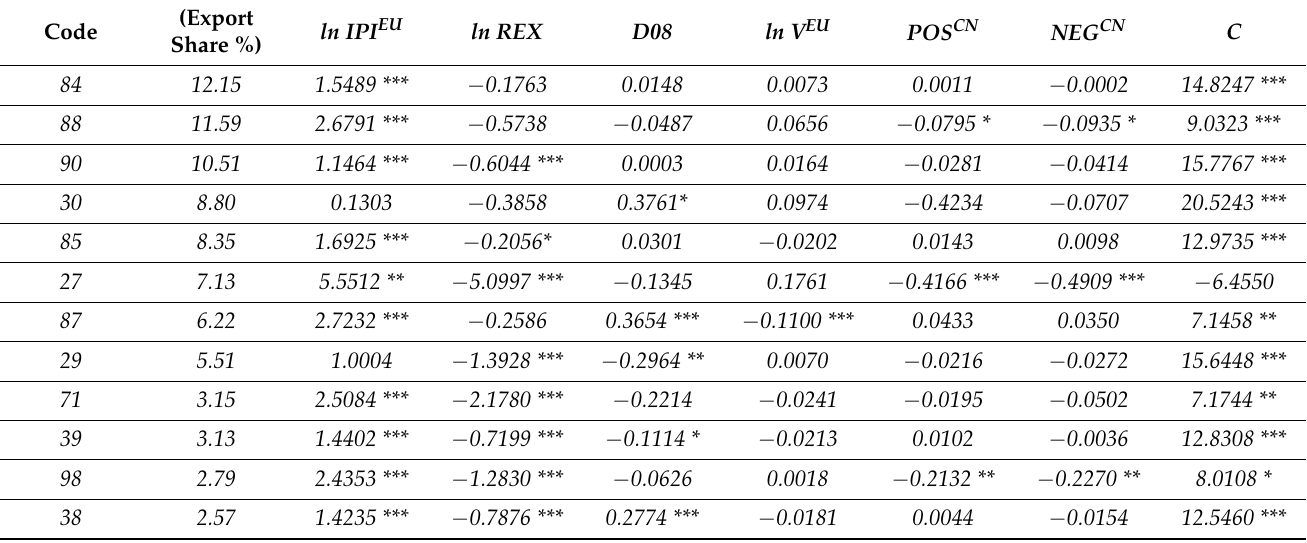
Table A1. Long-run coefficient estimates on the US exports to the EU with dummy and third country effects in the nonlinear ARDL model (8).